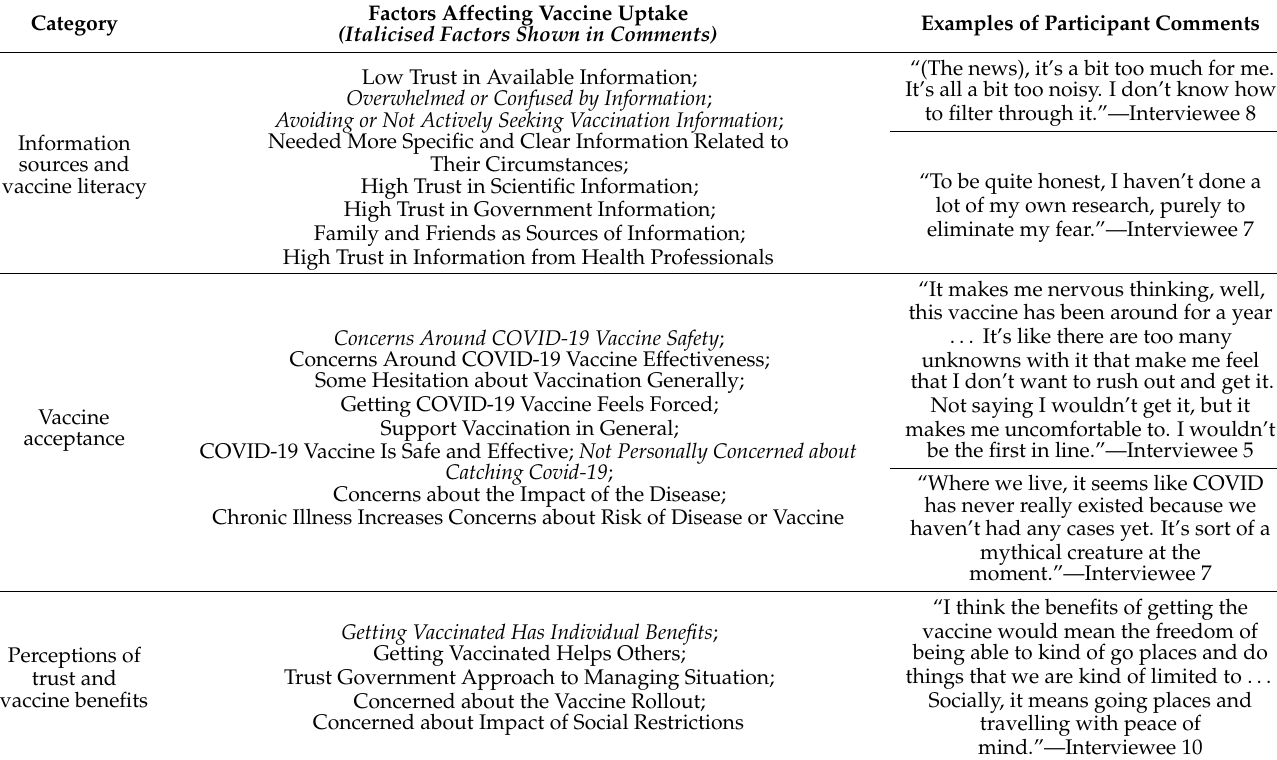
Table 4. Key observations of the